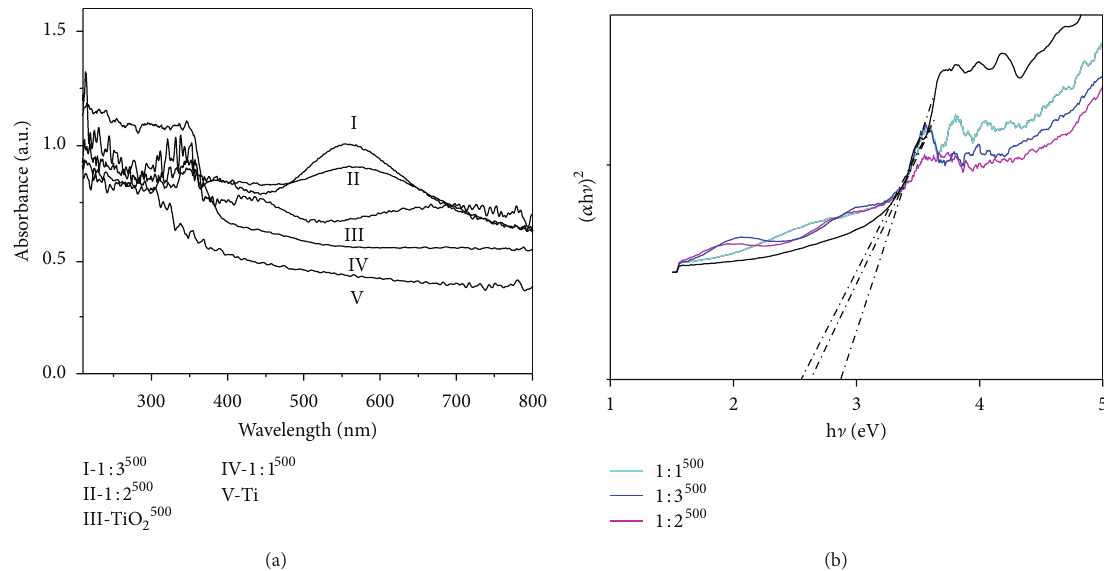
Figure 4: (a) UV-Vis DRS spectra for Ti, TiO 2 -500, and codoped TiO 2 -500 plate electrode and the corresponding plot of transformed Kubelka-Munk versus energy of light for TiO 2 -500 and codoped TiO 2 -500.